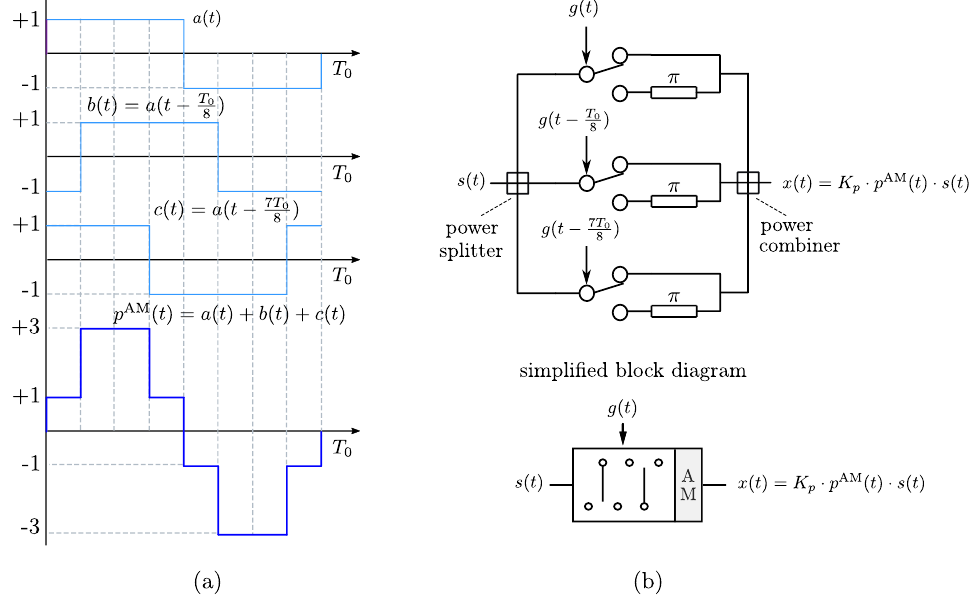
Figure 4. ( a ) Implementation of the periodic AM modulating pulse p AM ( t ) from three periodic bipolar square pulses shifted in time. ( b ) SPDT architecture capable of time modulating an input signal s ( t ) with p AM ( t ) (top) and its simplified block diagram